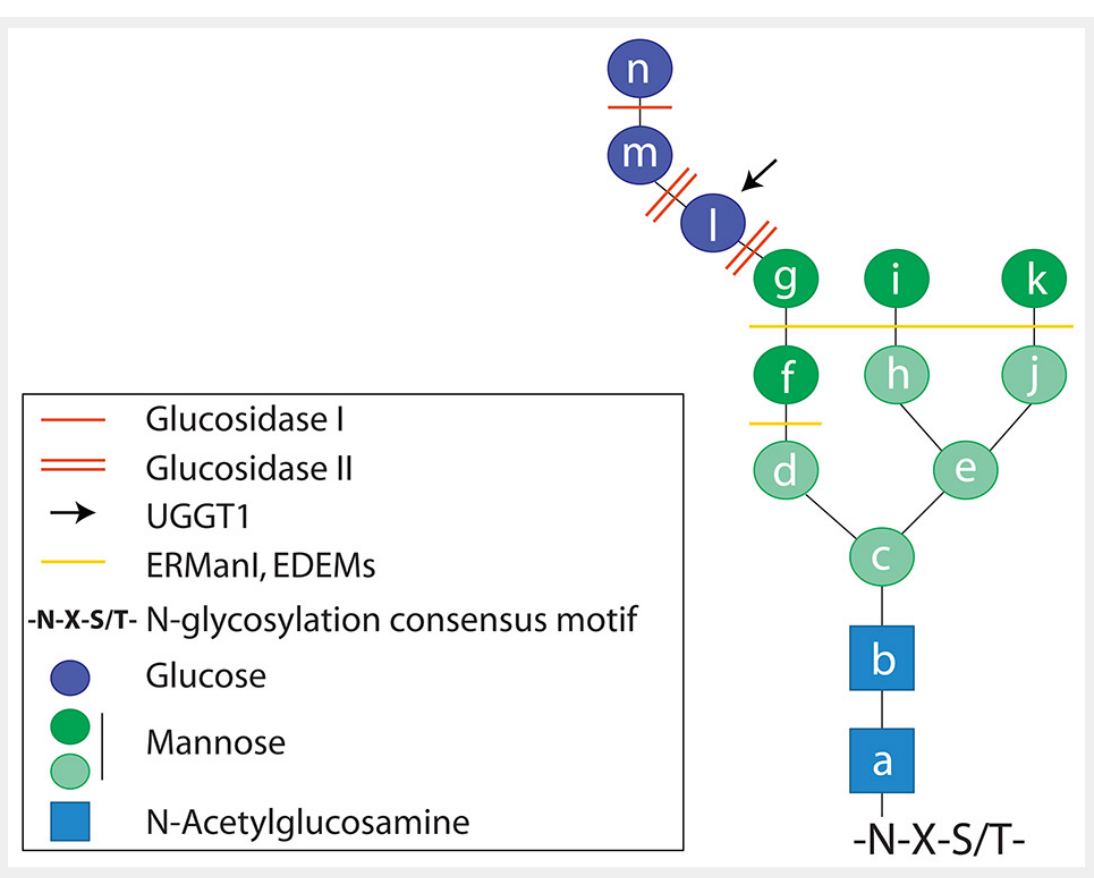
Figure 1 Structure of the N-linked oligosaccharide. The oligosaccharide is covalently bound to the side chain of asparagine residues in asparagine(N)- any aminoacid(X)-serine(S) or threonine(T) consensus